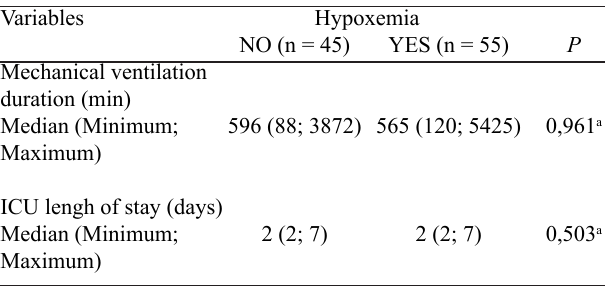
Table 3. Correlation between mechanical ventilation and permanence in the ICU, and hypoxemia time